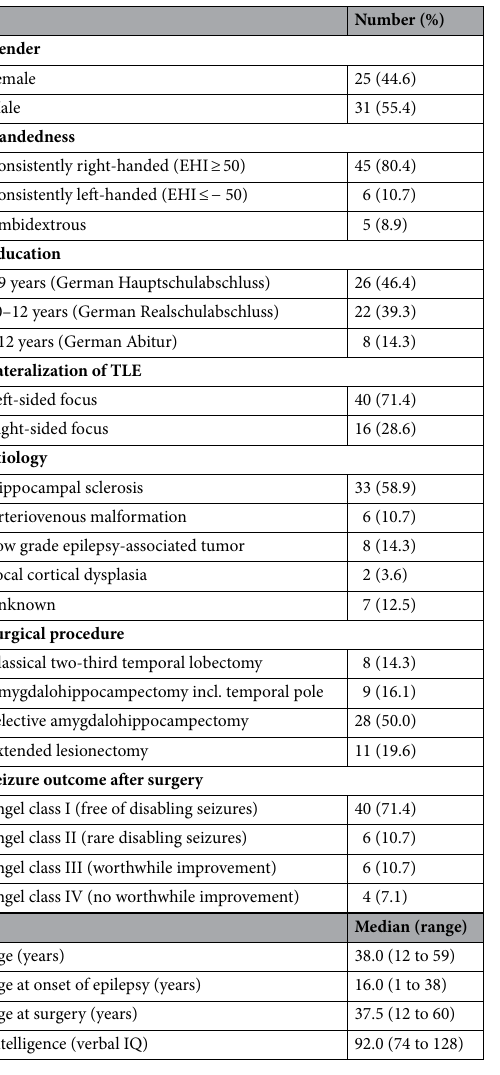
Table 1. Socio-demographic and clinical characteristics of the sample ( n =